Question: Give a one-sentence summary of this figure.
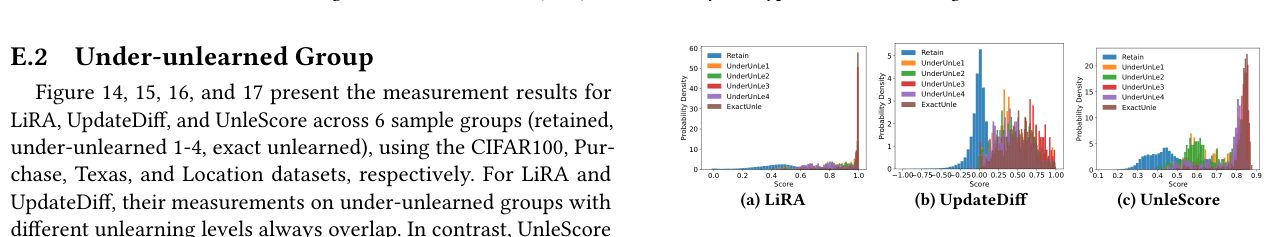
Answer: Scores of unlearning metrics on retained, under-unlearned, and exact unlearned groups within Texas.